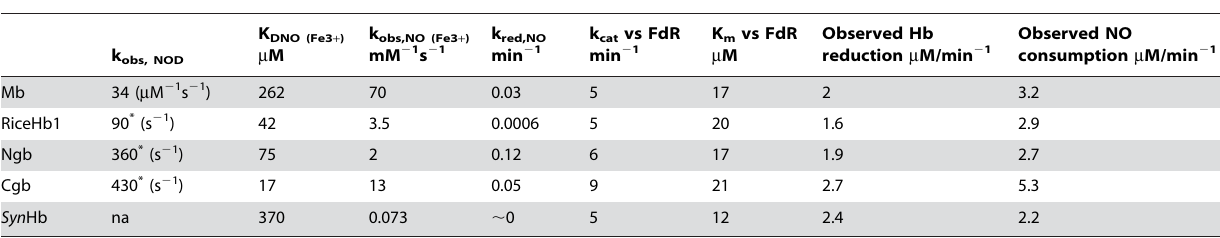
Table 1. Kinetic and affinity values for in vitro reactions with NO and heme iron reduction.